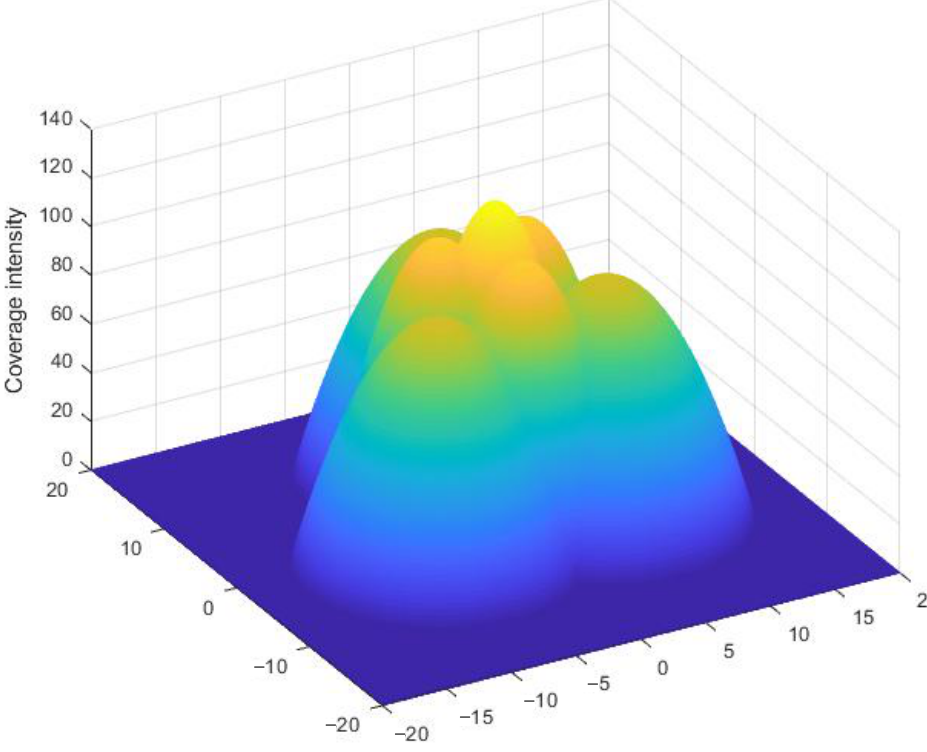
Figure 8. Three-dimensional illustration of coverage intensity of the 3-node team equipped with a concave model of coverage, in an equilateral triangle formation, with the nodes located on its vertices. The z -axis is the coverage intensity. r = 10. α =